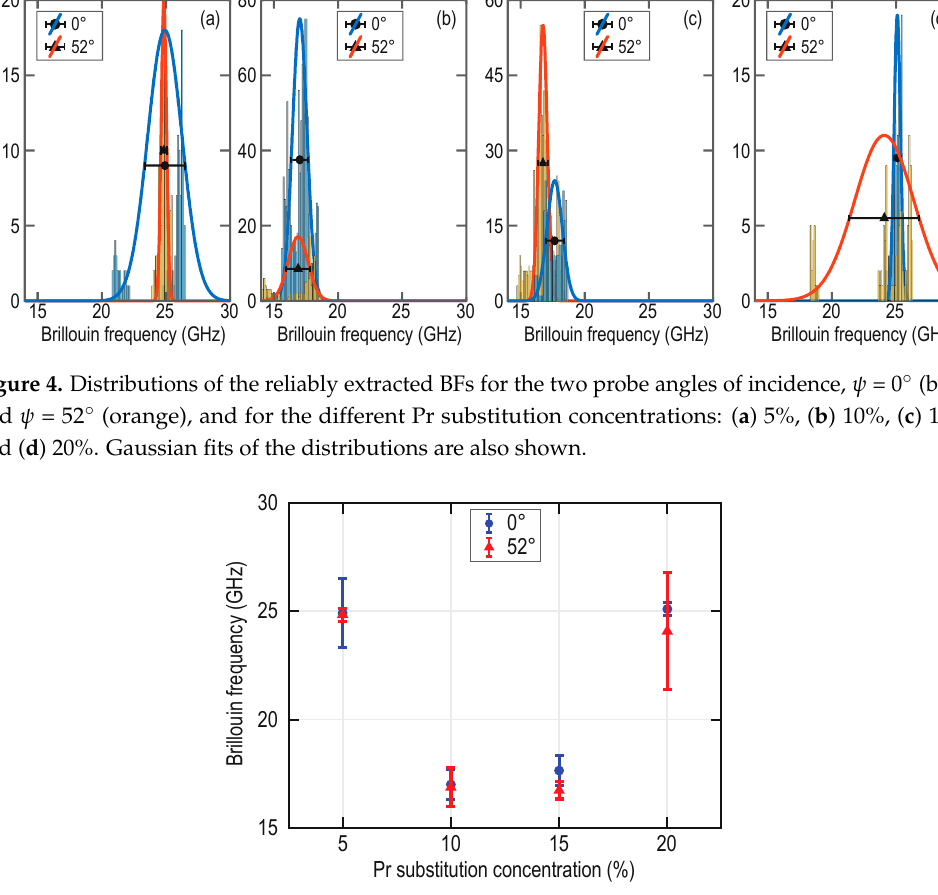
Figure 5. Average BF values as a function of the Pr substitution concentration for TDBS measurements at normal incidence ( ψ = 0°) with filled blue points and for those at oblique incidence ( ψ = 52°) with filled red triangles. The error bars in all cases are associated with the full width at half maximum (FWHM) of the distributions shown in Figure 4.